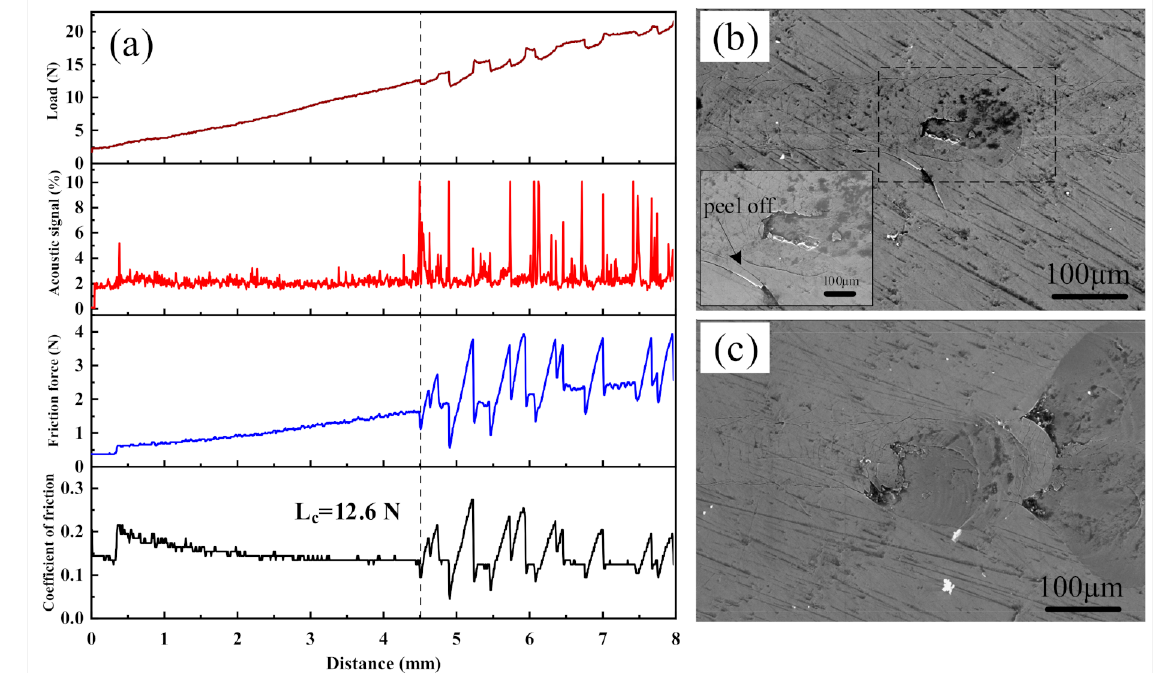
Figure 12. ( a ) Friction coefficient (COF) vs. lateral displacement curve combined with friction force and acoustic emission of Cr 2 AlC coating during the scratch test, SEM micrograph of ( b ) crack formation at critical load L c (inserted micrograph shows the coating peel off), and ( c ) scratch at maximum